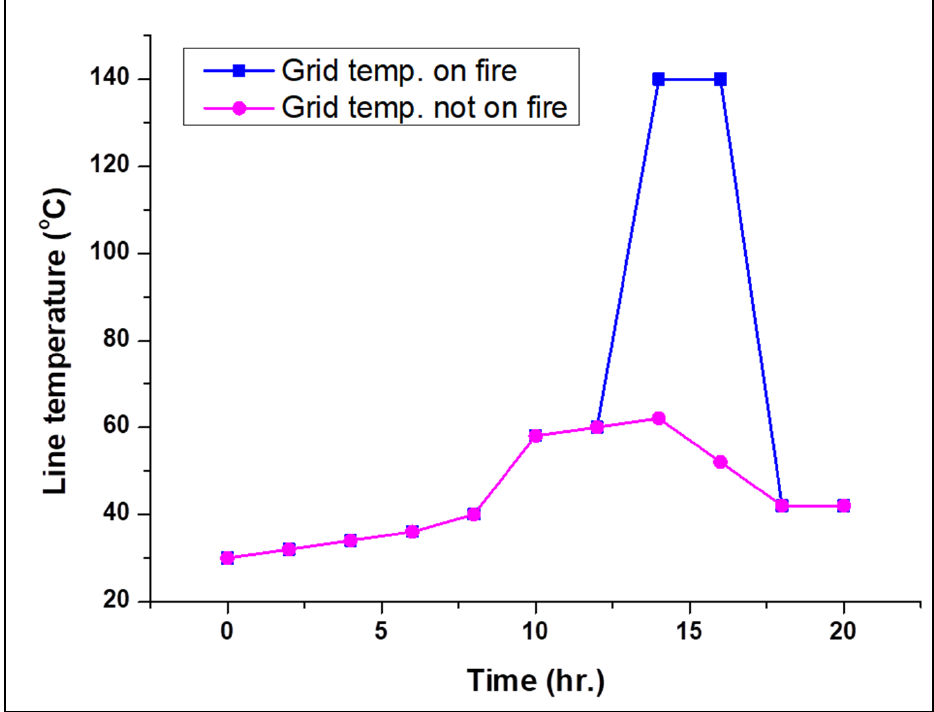
Figure 7. Transmission Line Temperature On/Not On Fire [71].